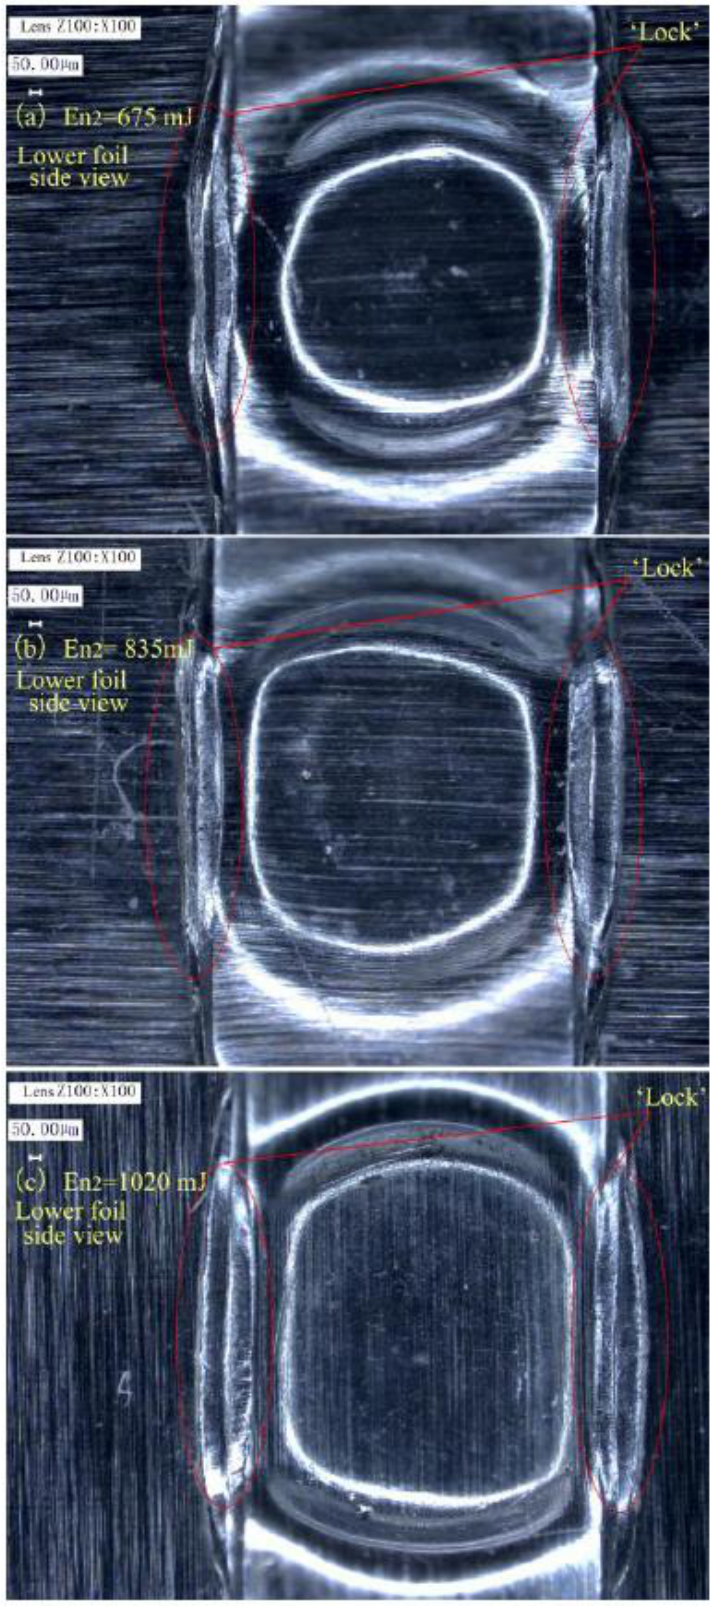
Figure 22. Joints produced under H of 500 μm, En 1 of 1550 mJ, and three different En 2 : ( a ) En 2 = 675 mJ; ( b ) En 2 = 835 mJ; and ( c ) En 2 = 1020 mJ. mJ; ( b ) En 2 = 835 mJ; and ( c ) En 2 = 1020